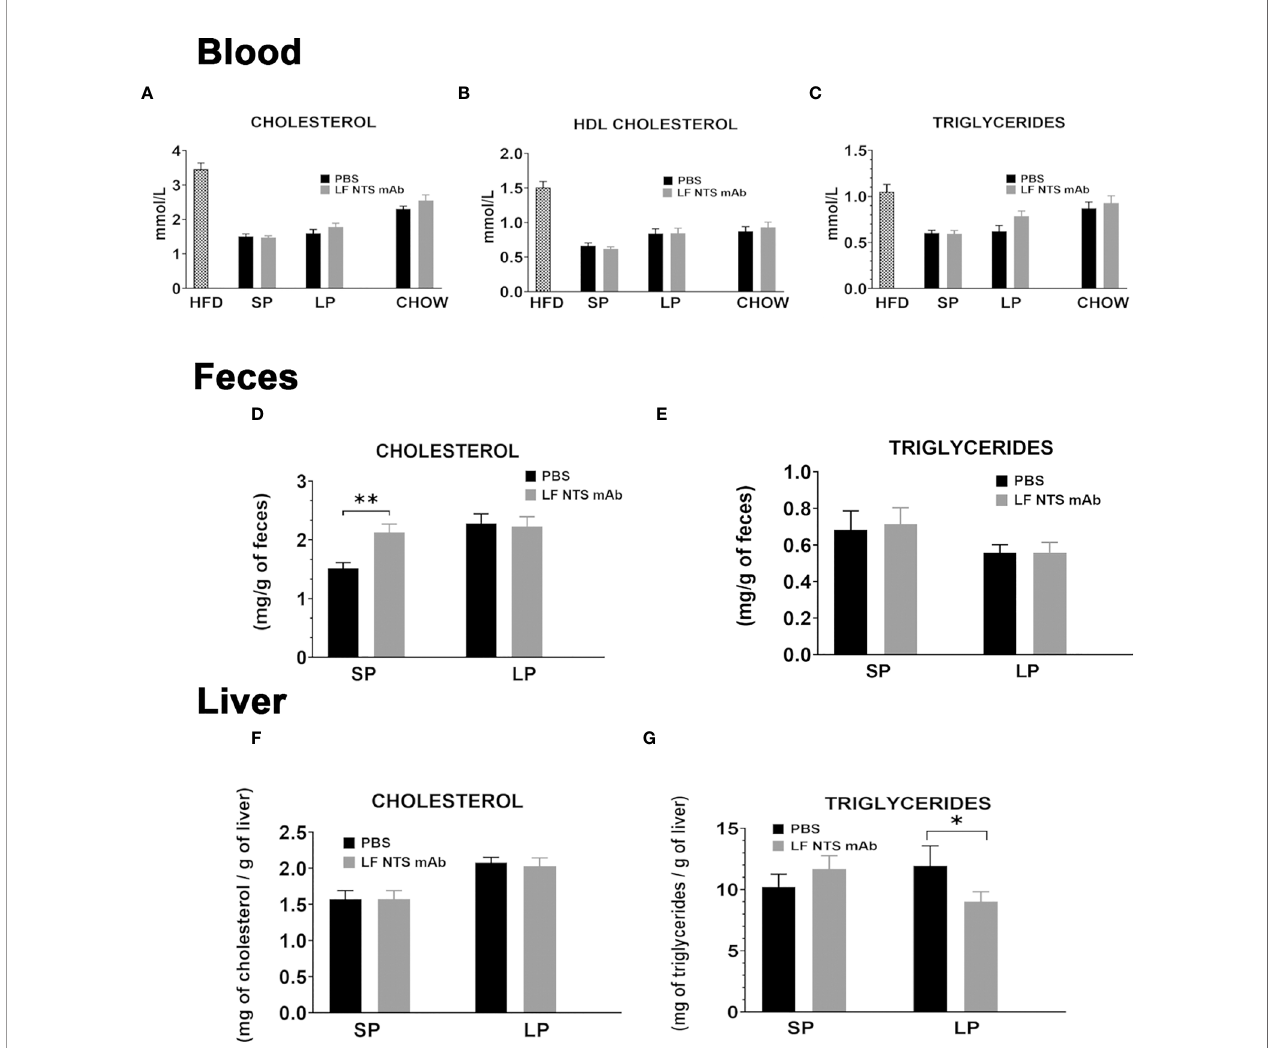
FIGURE 2 | Lipid content evaluated at SP and LP. (A – C) Lipid contents were measured in plasma before the switch (n = 17) on to two set of mice; at SP mean on two independent experiments (n = 21) and at LP (n = 10). Lipid levels were compared to maintained in chow and treated or not with LF NTS mAb (n = 10). Lipid content in feces (D, E) collected during the two phases, and in the liver (F, G) liver at the dissection see details in the methods section. t test *p < 0.05; **p <